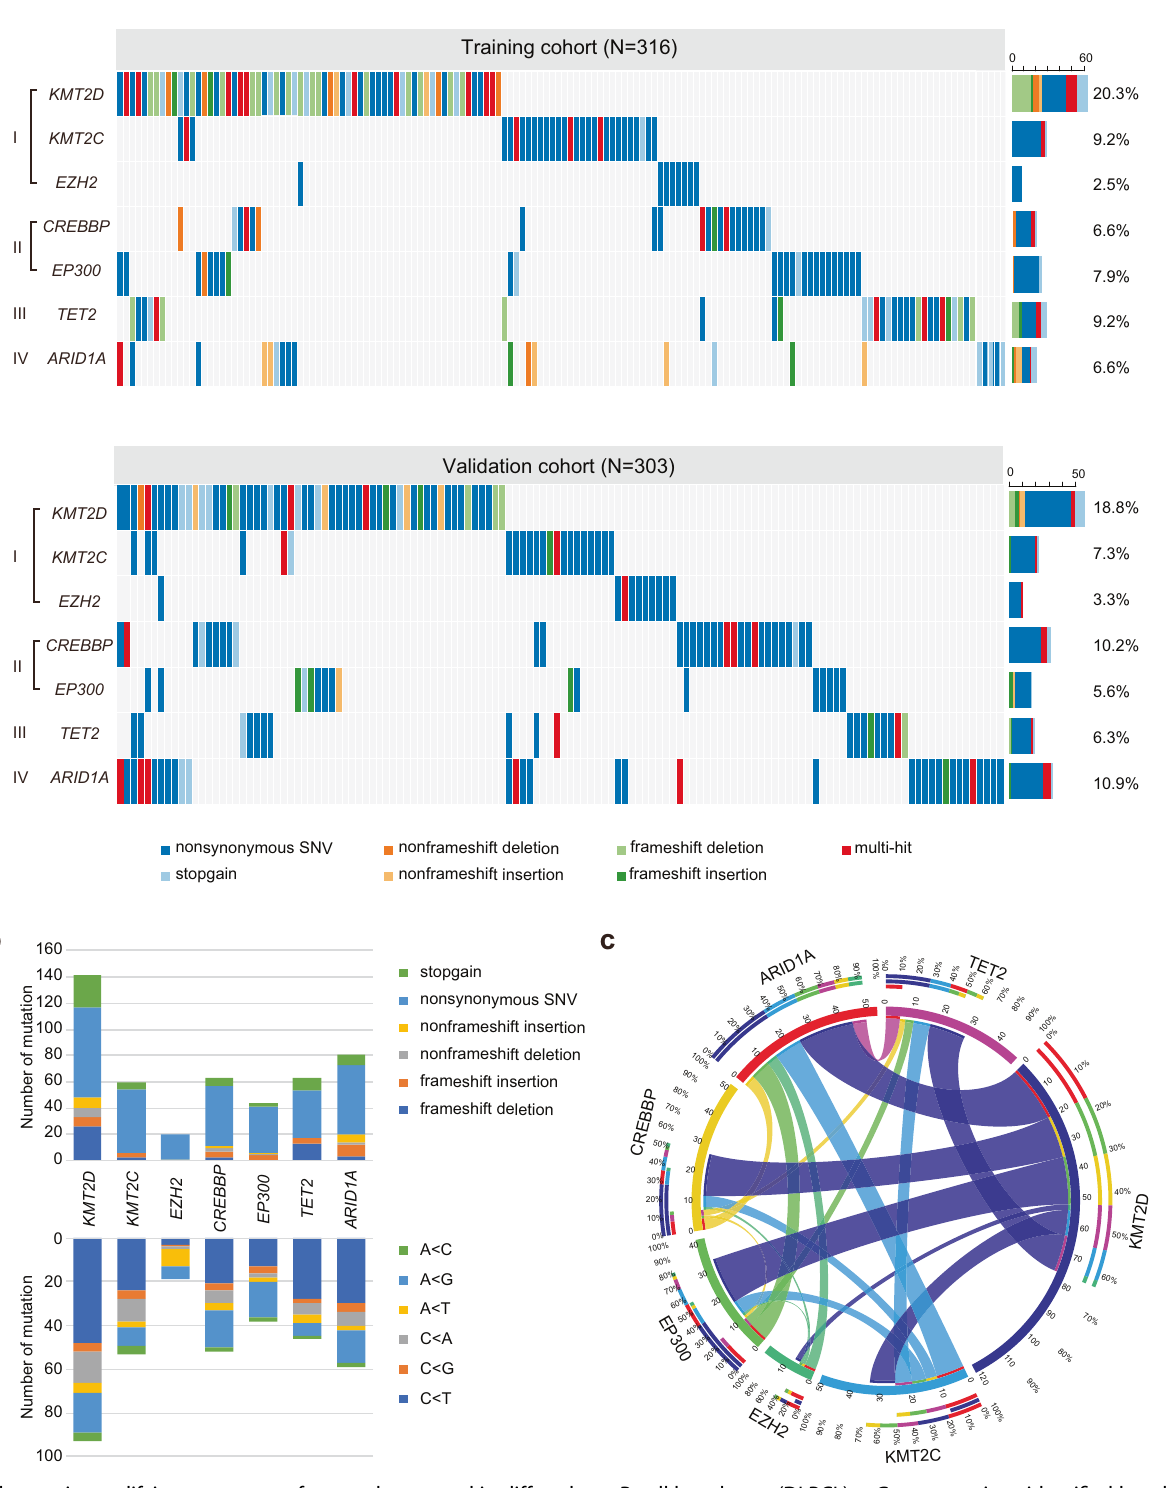
Fig. 1 Chromatin-modifying genes were frequently mutated in diffuse large B-cell lymphoma (DLBCL). a Gene mutations identi fi ed by whole- genome/exome sequencing (WGS/WES) in the training cohort of 316 patients (upper panel) and by targeted sequencing in the validation of 303 patients (lower panel) with DLBCL. b Type and a number of non-silent somatic mutations (upper panel), and the number of non-silent somatic single-nucleotide variants (SNVs) identi fi ed by WGS/WES/targeted sequencing (lower panel) in the training and validation cohorts of 619 DLBCL patients. c Circos diagram of the correlation between genes, representing the combinations of mutations in different genes